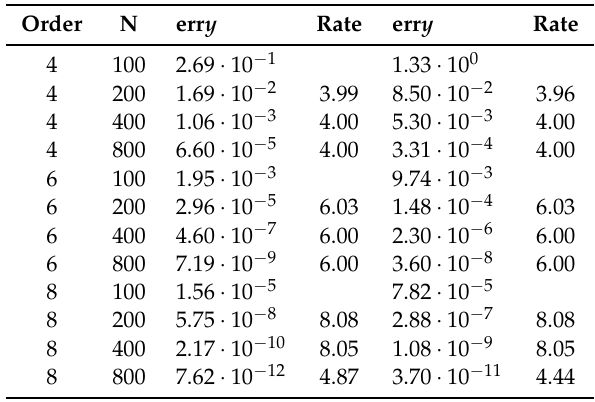
Figure 2. Kepler problem: results for the sixth (BSHO6, red dotted line) and eighth (BSHO8, purple dotted line) order BSHO methods, sixth order Euler–Maclaurin method (EMHO6, blue solid line) and sixth (Gauss–Runge–Kutta (GRK6), yellow dashed line) and eighth (GRK8-green dashed line) order Gauss methods. ( Top-left ) Absolute error of the numerical solution; ( top-right ) error in the Hamiltonian function; ( bottom-left ) error in the angular momentum; ( bottom-right ) error in the second component of the Lenz vector. Table 3. Kepler problem: maximum absolute error of the numerical solution and its derivative computed for 10